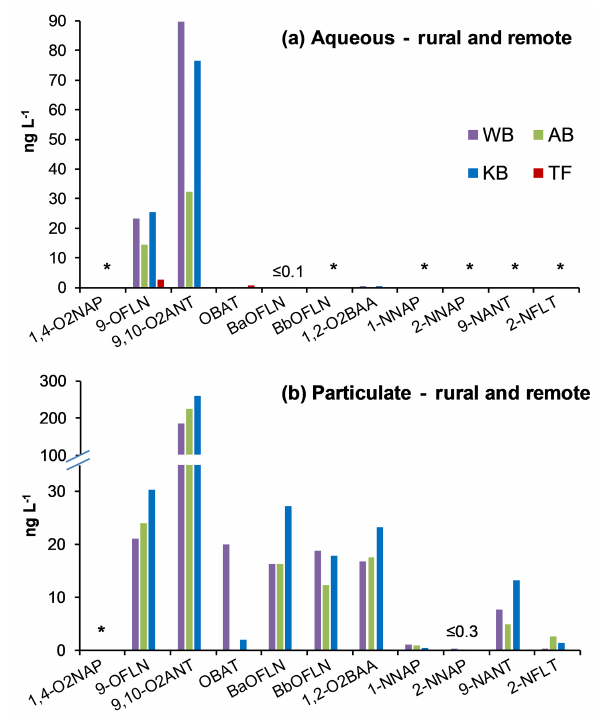
Figure 1. N/OPAHs in urban snow samples; ∗ indicates values <LOQ in all samples.